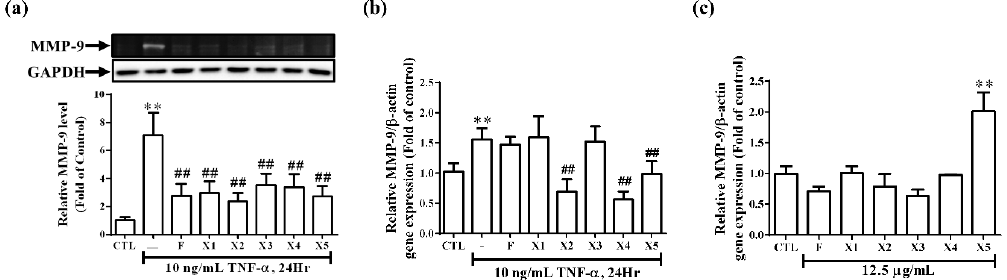
Figure 6. Effect of ferrocene-1 H -1,2,3-triazole hybrids on MMP-9 expression in RMCs. RMCs were treated with ferrocene-1 H -1,2,3-triazole hybrids (12.5 µ g / mL) for 2 h and then exposed to TNF- α